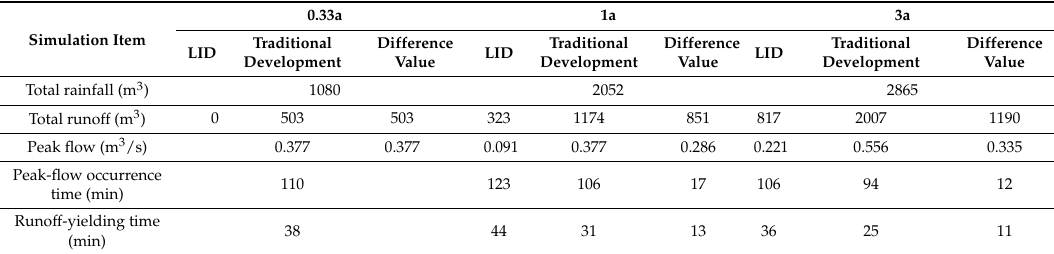
Figure 6. Comparison curve of runoff control effect: ( a ) when rainfall repetition period is 0.33a; ( b ) when rainfall repetition period is 1a; ( c ) when rainfall repetition period is 3a; ( d ) when rainfall repetition period is 5a; ( e ) when rainfall repetition period is 10a. Table 3. Simulated results of the runoff under different rainfall intensities.